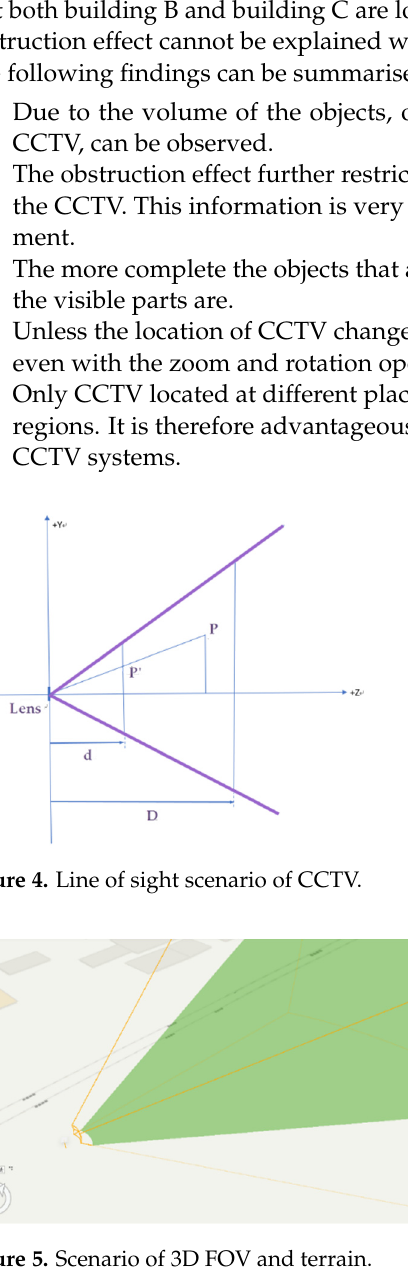
Figure 6. 3D FOV and the obstruction of a single object. Figure 7. 3D FOV and obstruction of multiple objects. •